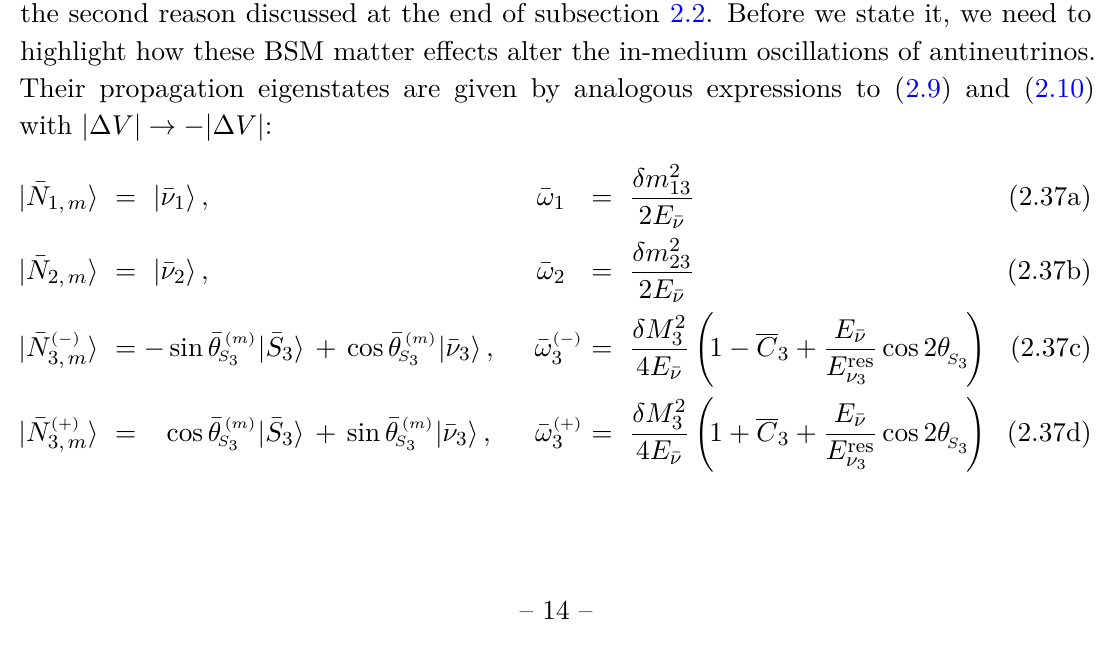
) as a function of (anti-)neutrino energy, assuming 32 ,eff (cid:12) (cid:12) (cid:12) ’ E res ’ E res ∼ 185 MeV. The data (cid:12) (cid:12) (cid:12) ν 3 ν 3 ν 3 T2K NO ν A MINOS by long-baseline accelerator 32